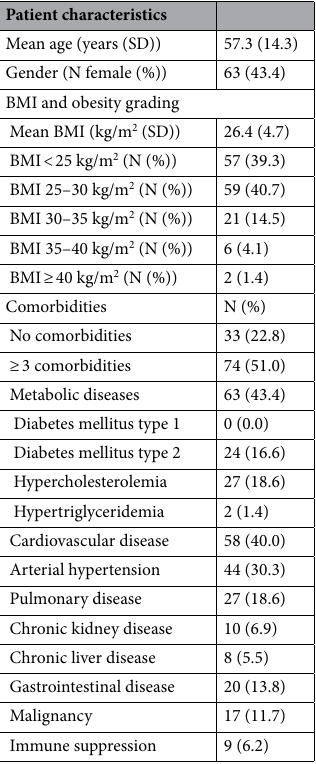
Table 1. Baseline characteristics of the study cohort (N =